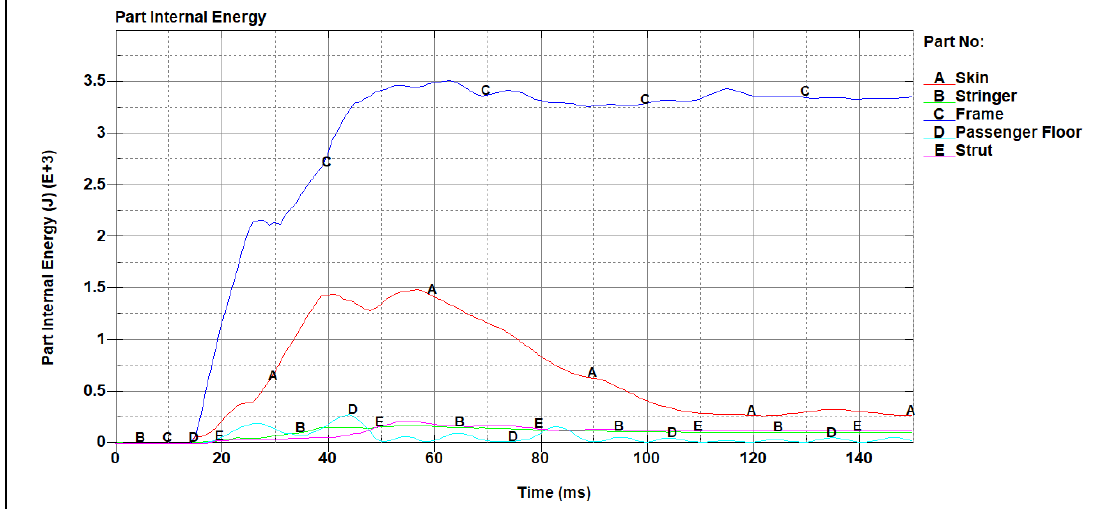
Figure 11: Internal energy plot for Aluminium fuselage at 7